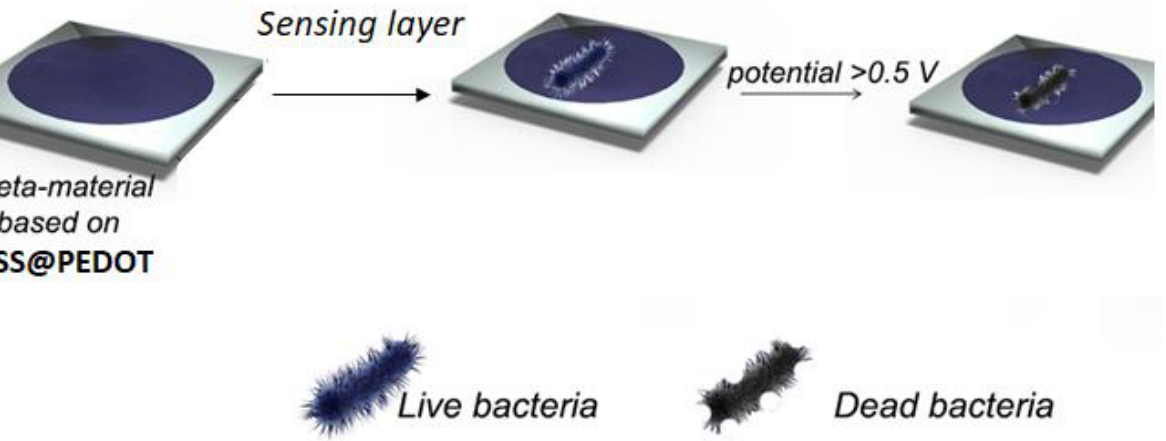
Scheme 1. Schema of experimental concept for creation of meta-materials based on PNaSS@PEDOT